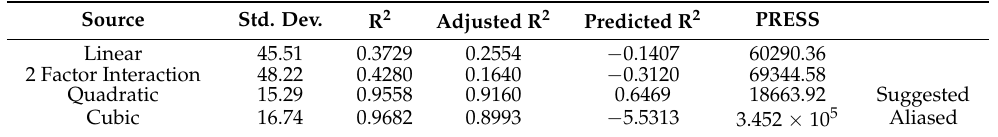
Table 7. The coefficients of determination.